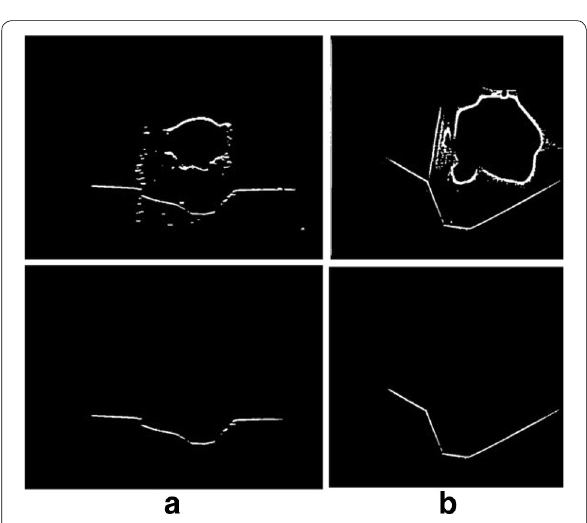
Figure 15 Verification results using the first simplified method: a θ = ± 10 ◦ for Gabor filtering, b θ = ± 10 ◦ , − 80 ◦ for Gabor